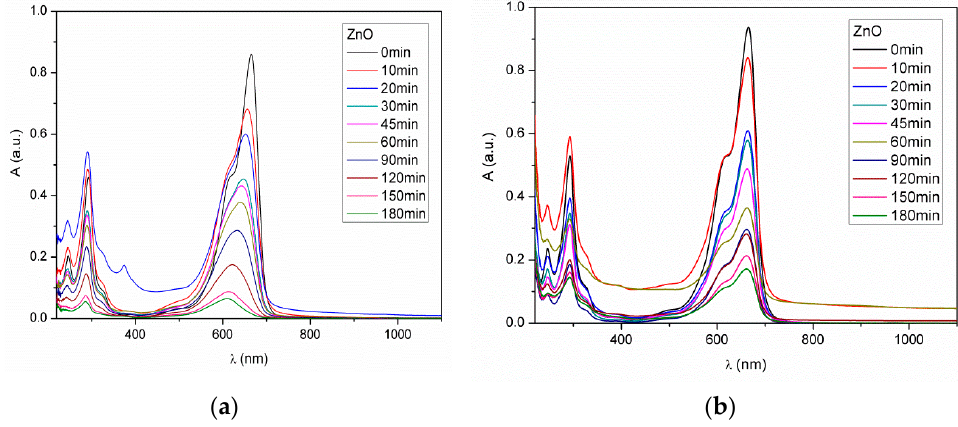
Figure 11. UV–Vis spectra collected during the MB degradation versus reaction time on the ZnO(C) catalyst, under UV irradiation and ( a ) in the absence of the Na 2 CO 3 /NaHCO 3 buffer and ( b ) in the presence of the Na 2 CO 3 /NaHCO 3 buffer.